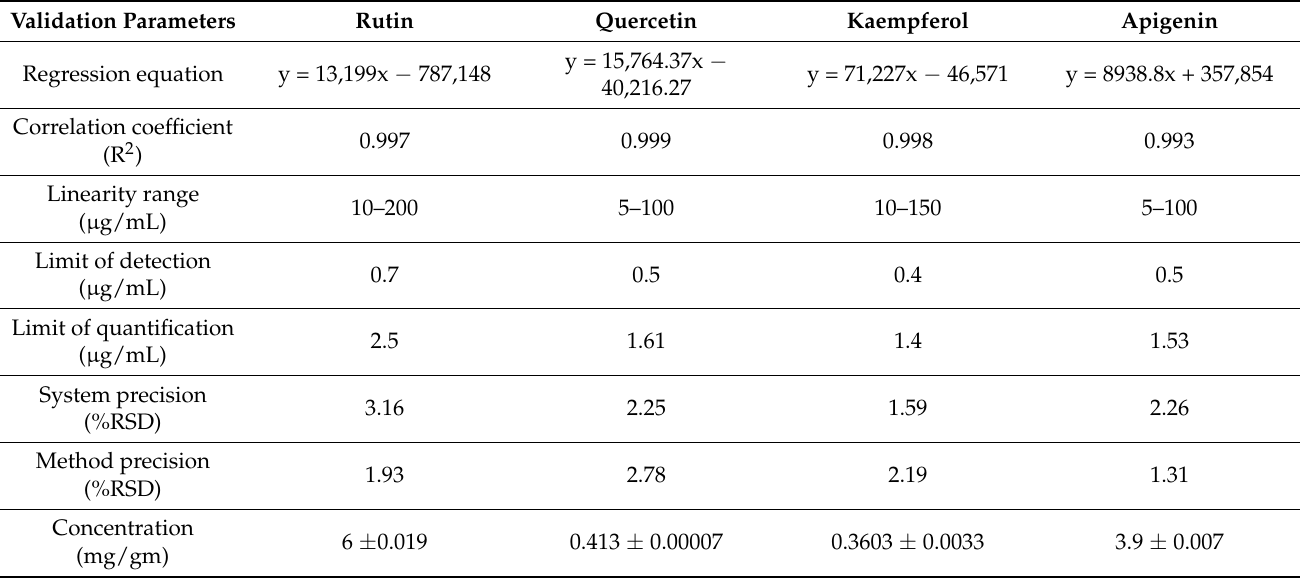
Table 6. Validation parameters of the HPLC method for the simultaneous quantification of rutin, quercetin, kaempferol, and apigenin scanned at λ = 280